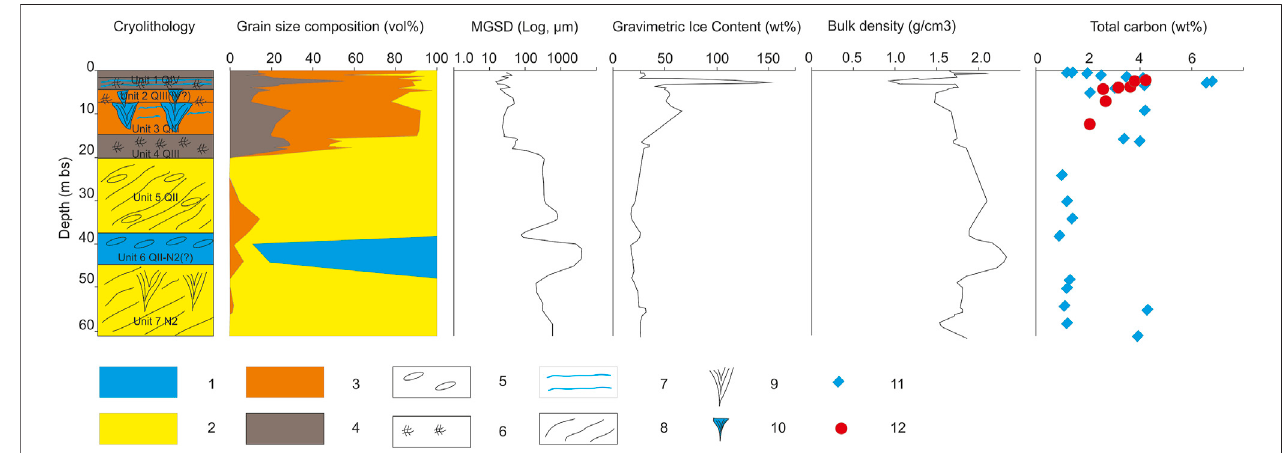
FIGURE 4 | Characteristics of the Mamontova Gora outcrop (Vterrace). Legend: 1)pebbles, 2)sand, 3)silt, 4)loam, 5)boulders and gravels, 6)peat and organic inclusions, 7)ice layers, 8)lithological layering, 9)pseudomorphs, 10)ice wedges, 11)total carbon content is the sediments, 12)total carbon content in soil particles of the ice wedges (relative to the dried soil